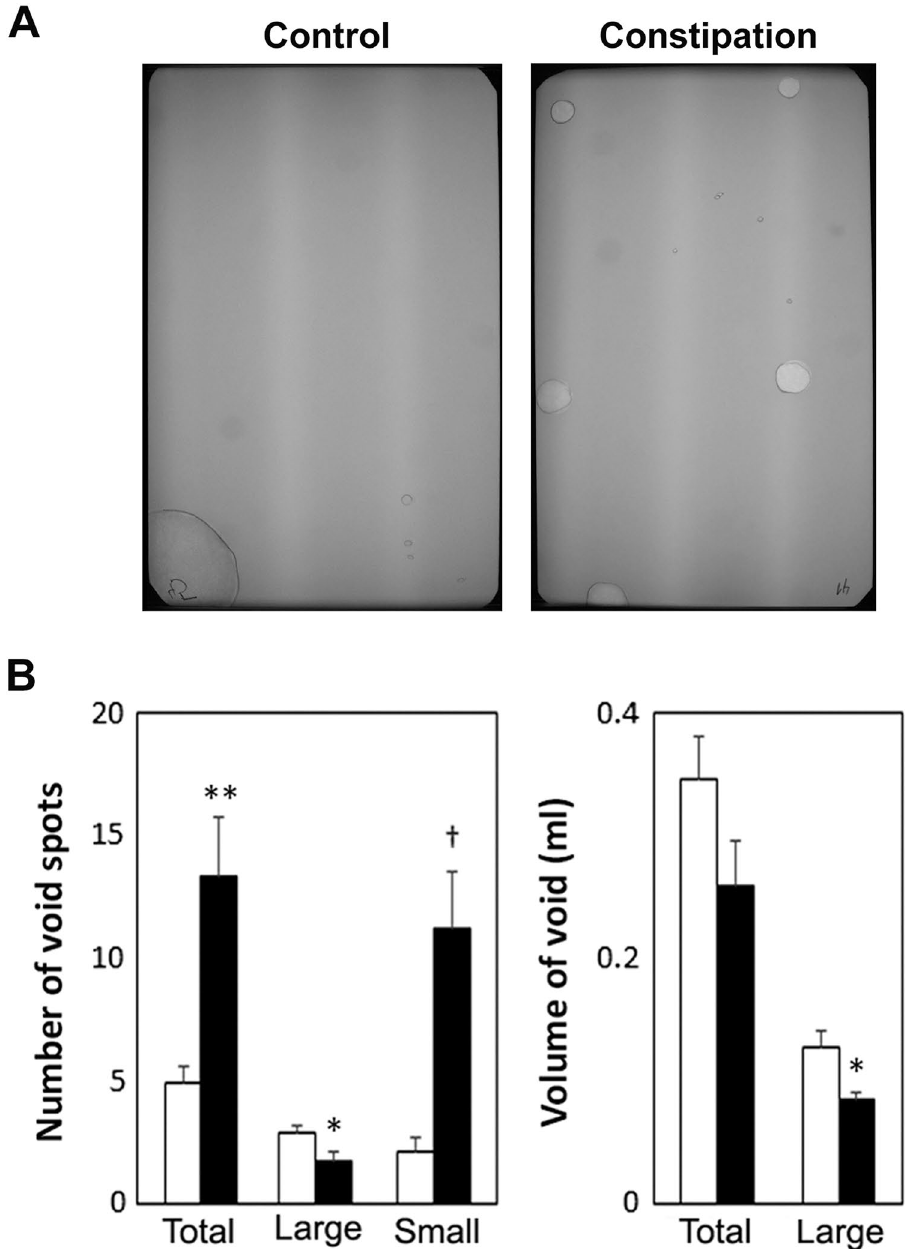
Figure 2. Micturition patterns at 4 days after the surgery. ( A ) Representative void spot assay images from each group. ( B ) Number of the urine spots (left), of large (≥ 50 μl) and small voids (< 50 μl). The voided volume (right) of total and per void in the large void spots. White and black bars represent the control and the constipation mice, respectively. Mean ± SE. *p < 0.05, **p < 0.005, † p < 0.0005 vs. the control mice. Figures were prepared using Adobe Photoshop CS6 and GraphPad Prism 8.4.3 (https ://www.graph pad.com/scien tific -softw are/prism